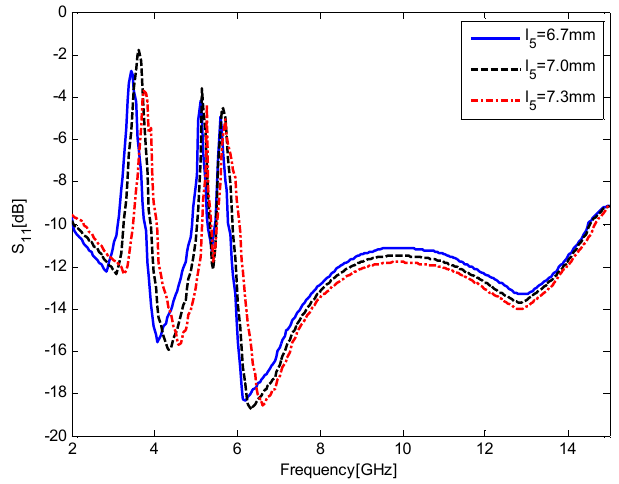
Figure 9. Simulated S 11 results for the antenna as a function of l 5 , the vertical length of the comb-shaped slot.